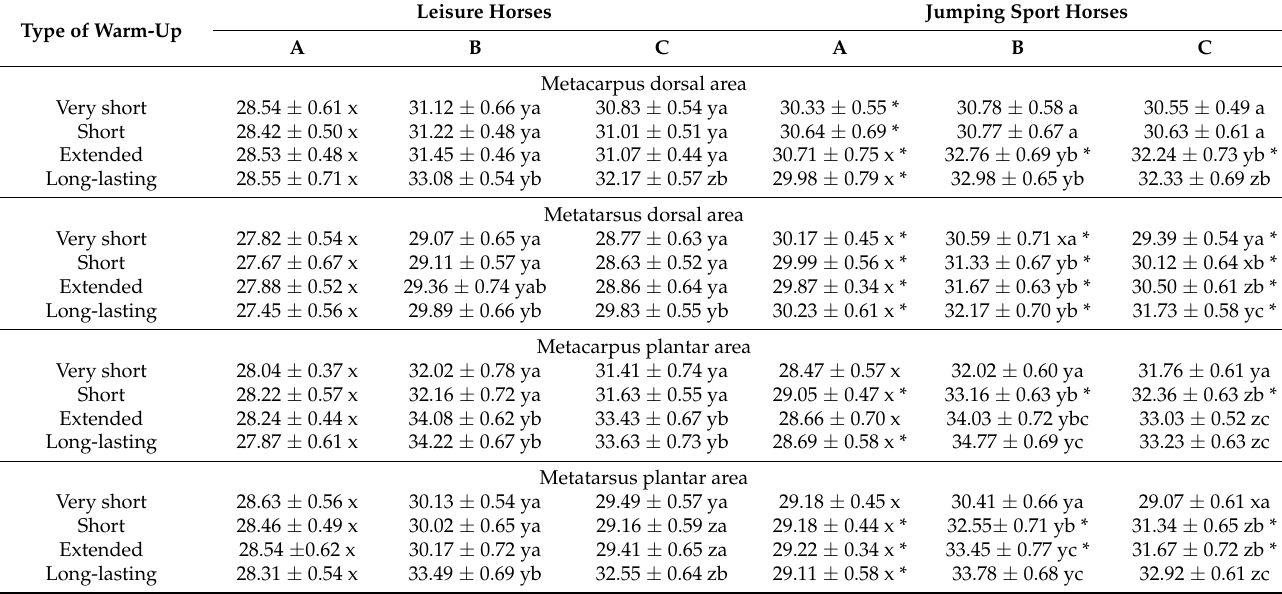
A—values obtained at rest, B—immediately after the end of warm-up, C—30 min after the end of warm-up. Means marked with different letters differ significantly at p < 0.05: x,y,z—in rows, between A, B, and C; a,b,c—in columns, between the types of warm-up; *—value higher in jumping sport horses in comparison to leisure